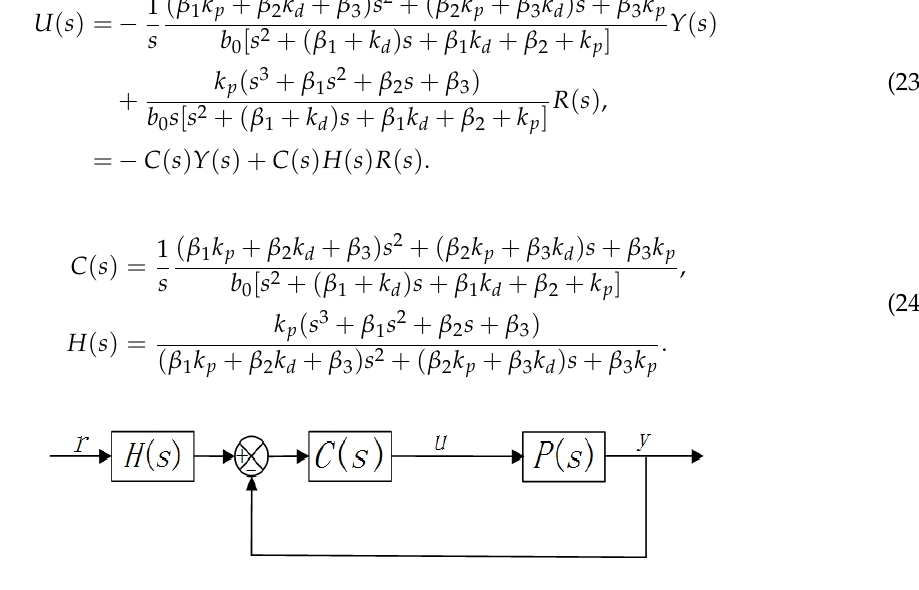
Figure 4. The transformation function block diagram of